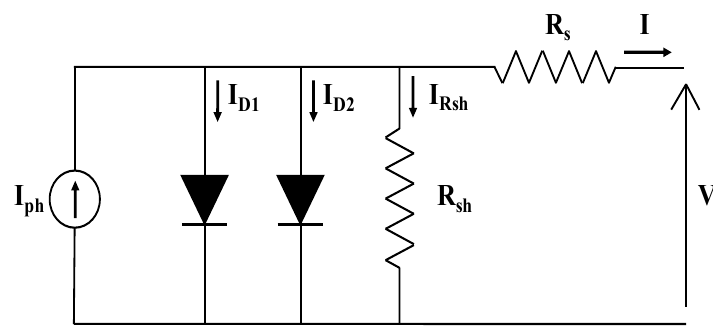
Figure 2. Double-diode equivalent-circuit model.